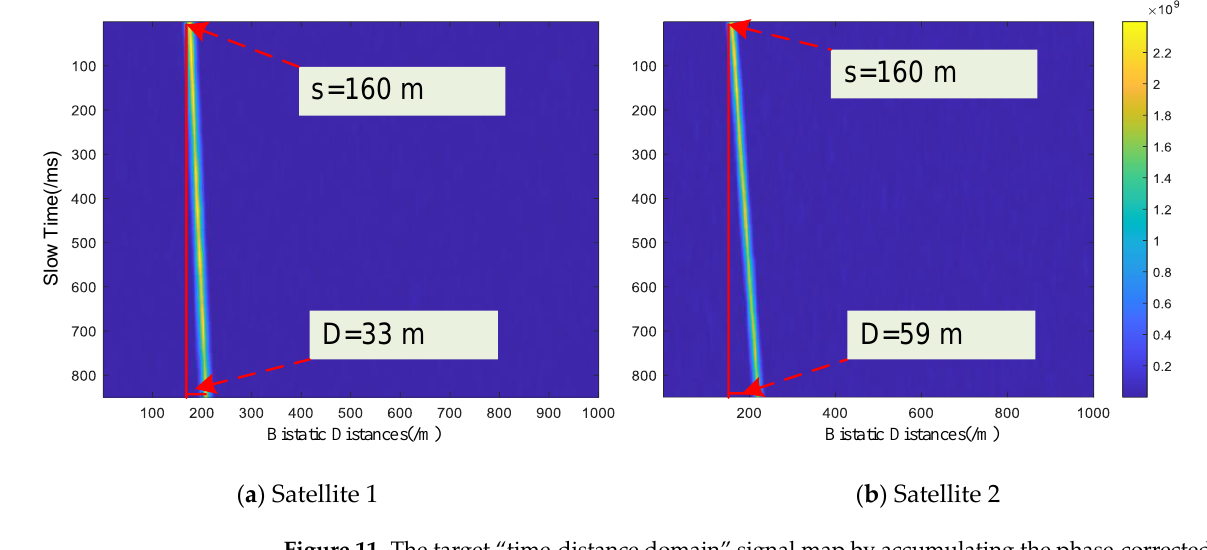
Figure 11. The target “time-distance domain” signal map by accumulating the phase-corrected data.